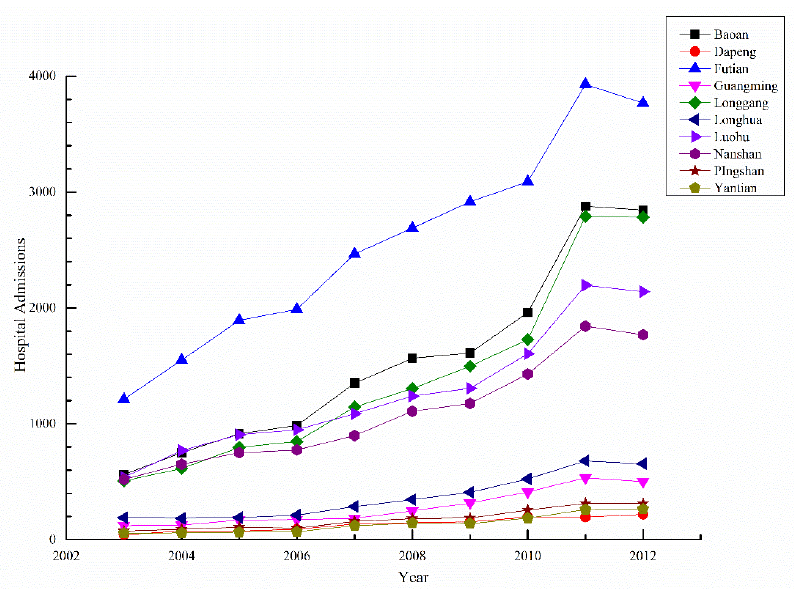
Figure 5. The IHD hospital admissions of each district in Shenzhen from 2003 to